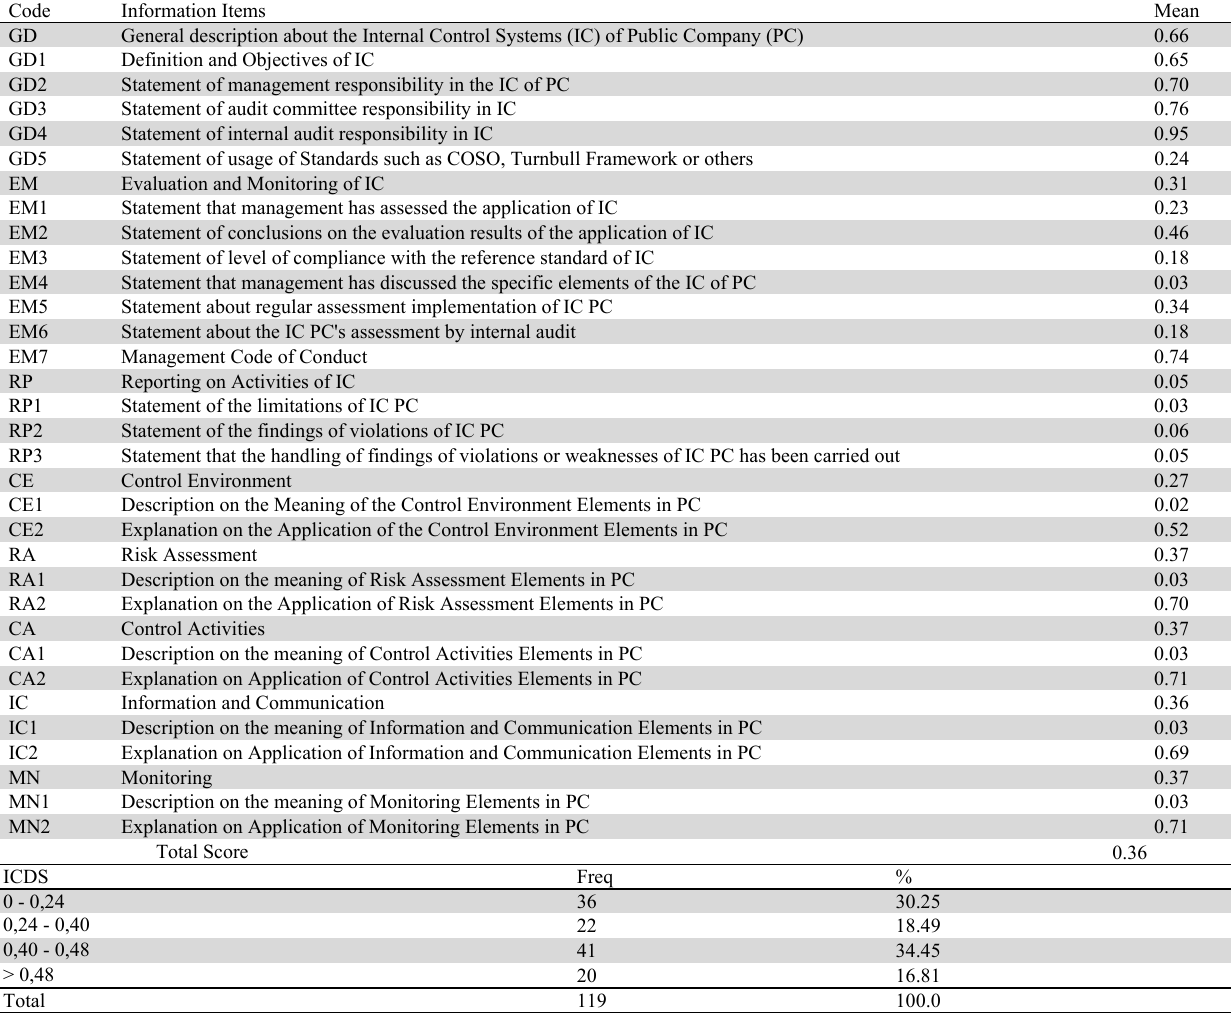
Internal Control Disclosure